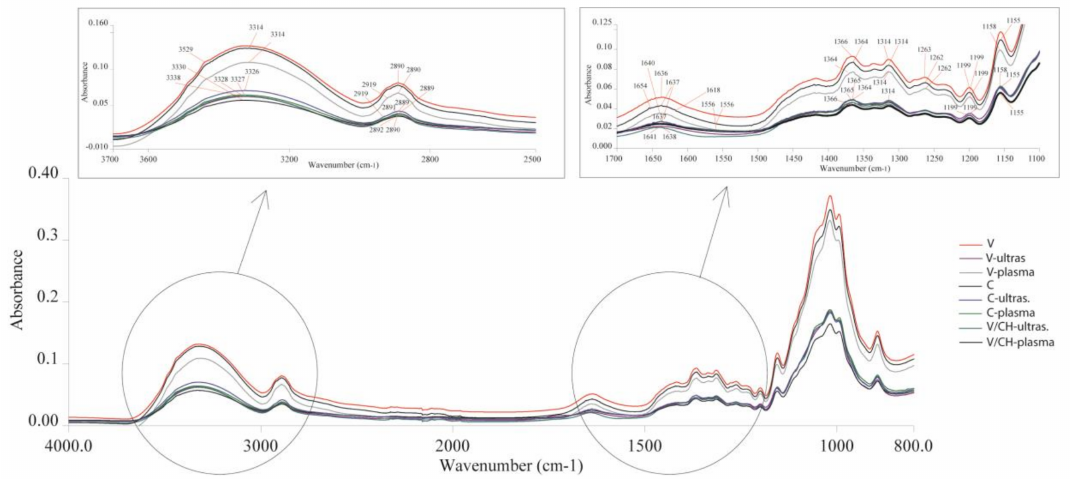
Figure 1. ATR FTIR spectra of all fibers in the range of 4000–800 cm − 1